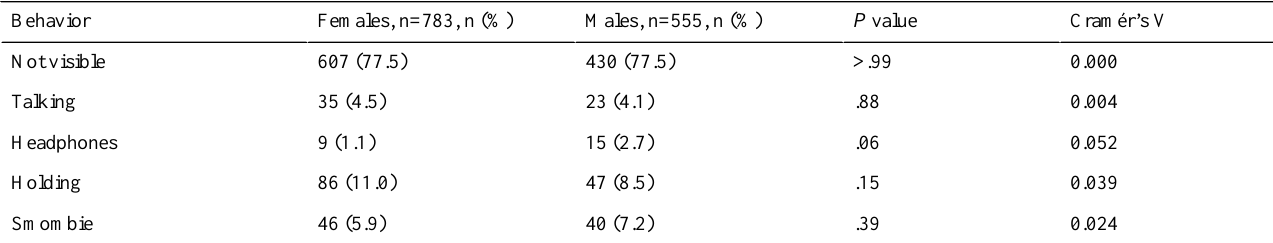
Table 7. Influence of gender on smartphone usage behavior in adults (n=1338, globally P =.11, V=0.074).